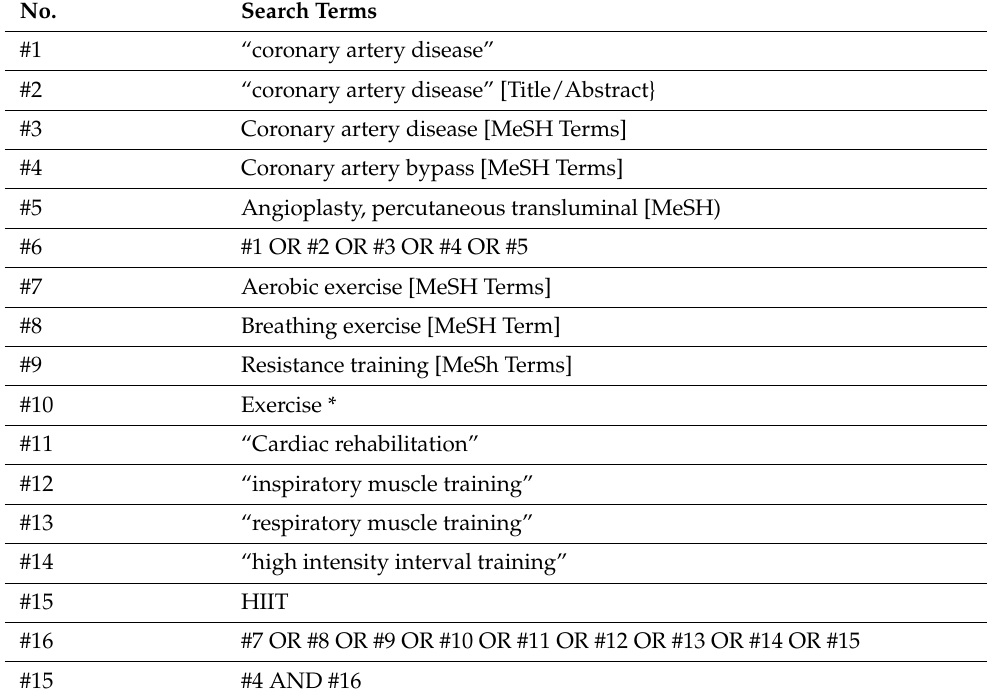
Table 2. Search String used in